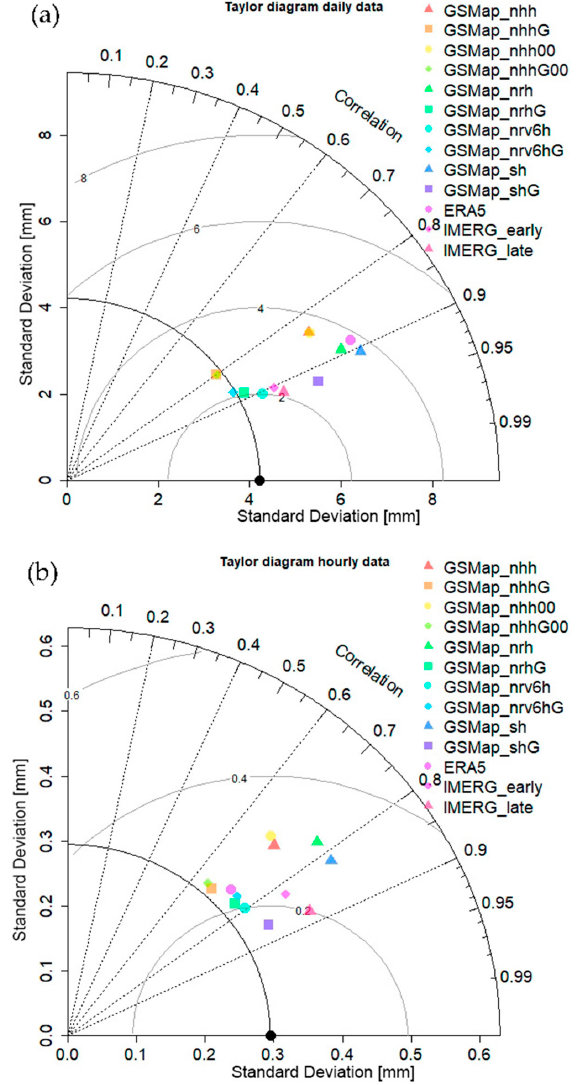
Figure 2. Catchment averaged daily ( a ) and hourly ( b ) precipitation of different near-global datasets compared against gauge-adjusted radar data using a Taylor diagram (Taylor [29]). The correlation is given by the angle to the y-axis (dashed lines). The standard deviation increases with distance to the origin of the coordinate system, and the standard deviation of the gauge-adjusted radar data is given as a reference (black arc). The root-mean-square error is given by the distance to the black dot on the x-axis (grey arcs).